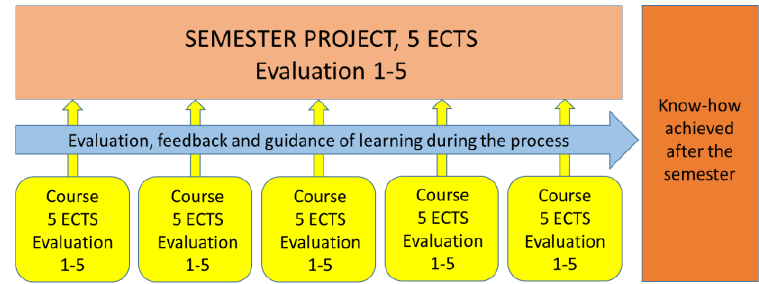
Fig. 6. Semester structure of the new curriculum